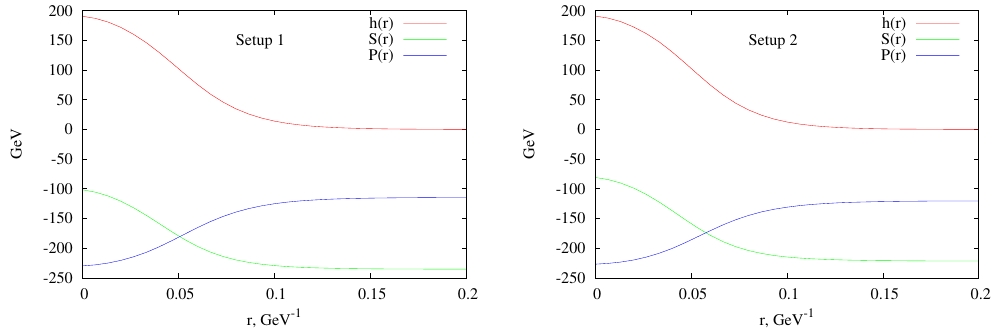
Figure 3 . The critical bubble pro(cid:12)les for the parameter set presented in tables 1 and 2. values of the (cid:12)elds, critical temperature, S In (cid:12)gure 4 we show baryon asymmetry as a function of wino mass parameter M revised benchmark setups. Finally, (cid:12)gure 5 contains limits on chargino and neutralino masses from the bounds on EDM of electron and